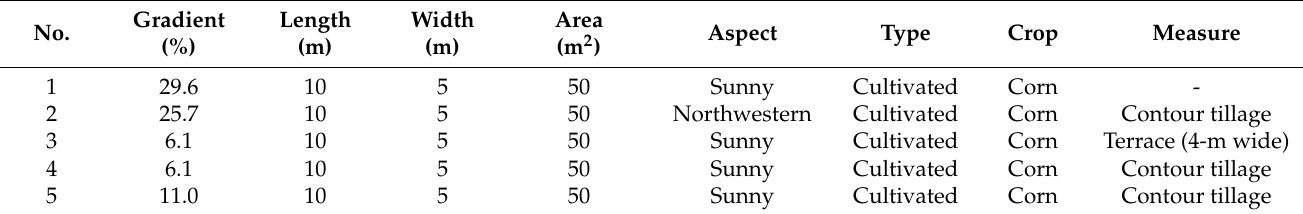
Table 1. Description of the selected runoff plots.